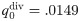
Motif dynamics in non-Erdös-Rényi networks.(A) Degree distribution of the finite-size Erdös-Rényi networks used in Figs 2–9, showing each neuron’s number of incoming synapses (in-degree) and outgoing synapses (out-degree). (B) Correlated, truncated power degree distributions. From left to right, the frequency of chain motifs increases. The degree distributions at either end of the “Chain Frequency” axis correspond to highly anti-correlated (left) and highly correlated (right) in- and out-degrees, with correlation coefficient ρ = ±.9 (Methods: Neuron and network models). The networks in columns ii-iv are drawn from the labelled points on this axis, with ρ = −.1 (ii), ρ = .1 (iii) and ρ = .5 (iv). In each column, we sample networks from each side of threshold for potentiation of p. For the network in column ii, q0div=.0149, q0con=.0163, q0ch=−.0012. For the network in column iii, q0div=.0165, q0con=.0157, q0ch=7.7x10−4. For the potentiating network in column iv, q0div=.0161, q0con=.0157, q0ch=.0062. For the depressing network in column iv, q0div=.0148, q0con=.0156, q0ch=.0068. (C) Dynamics of the mean synaptic weight. (D) Dynamics of divergent motifs. (E) Dynamics of convergent motifs. (F) Dynamics of chain motifs. In all panels, the STDP rule is the balanced, depression-dominated one (−δ in Figs 6–9).